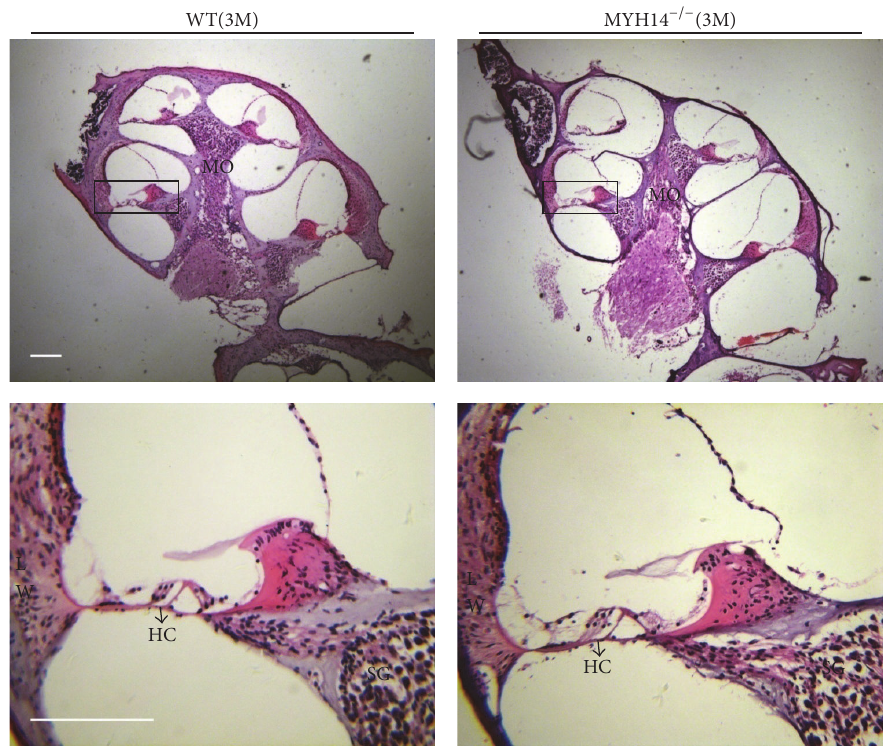
Figure 3: Myh14 −/− mice showed normal cochlear morphology. Cochlear morphology is normal in Myh14 −/− mutant mice. Cochlea stained with hematoxylin and eosin from 3-month-old control and Myh14 −/− mice. No prominent differences, including spiral ganglion (SGN) in modiolus (MO) and hair cells (HC), were found between wild type and mutant mice. Scale bar, 100 𝜇